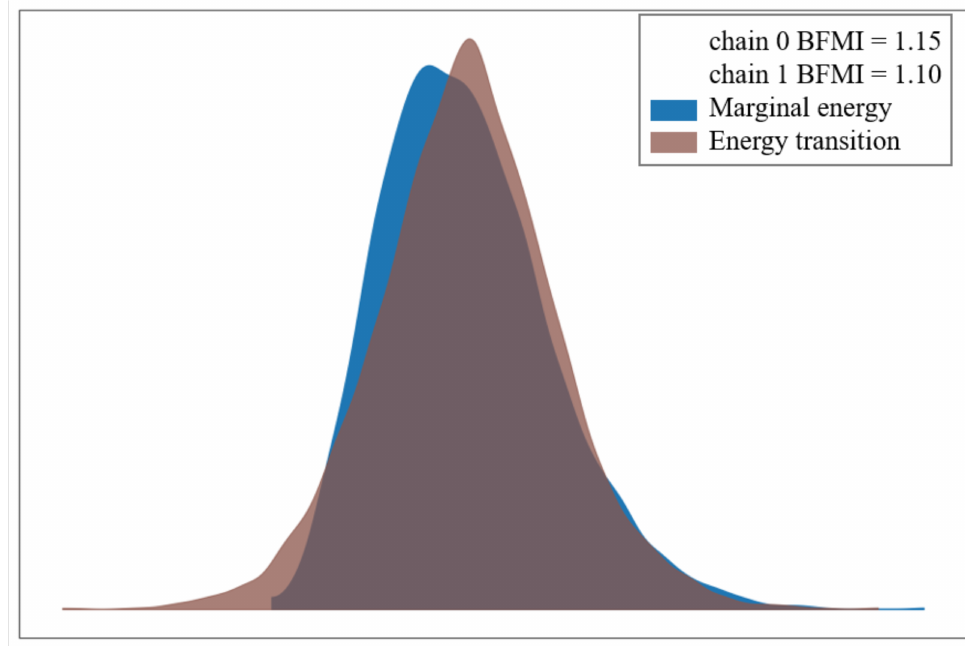
Figure 6. Analysis results of